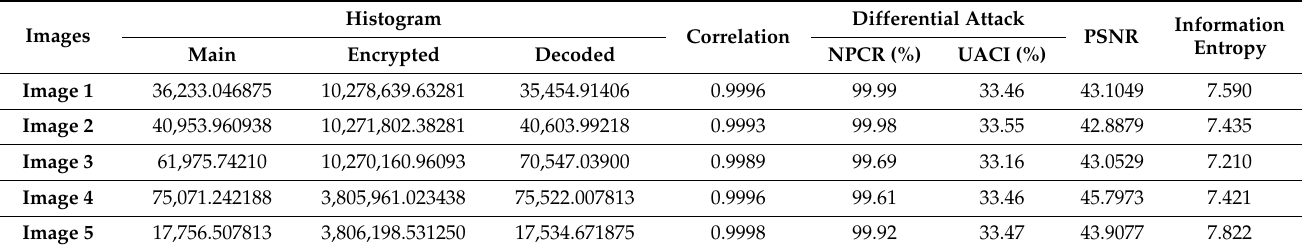
Figure 9. Displayed histograms for various Benchmark images encrypted using synchronization of the fractional-order chaotic system ( q = 0.97). Table 1. Statistical metrics Benchmark images ( q = 0.97).